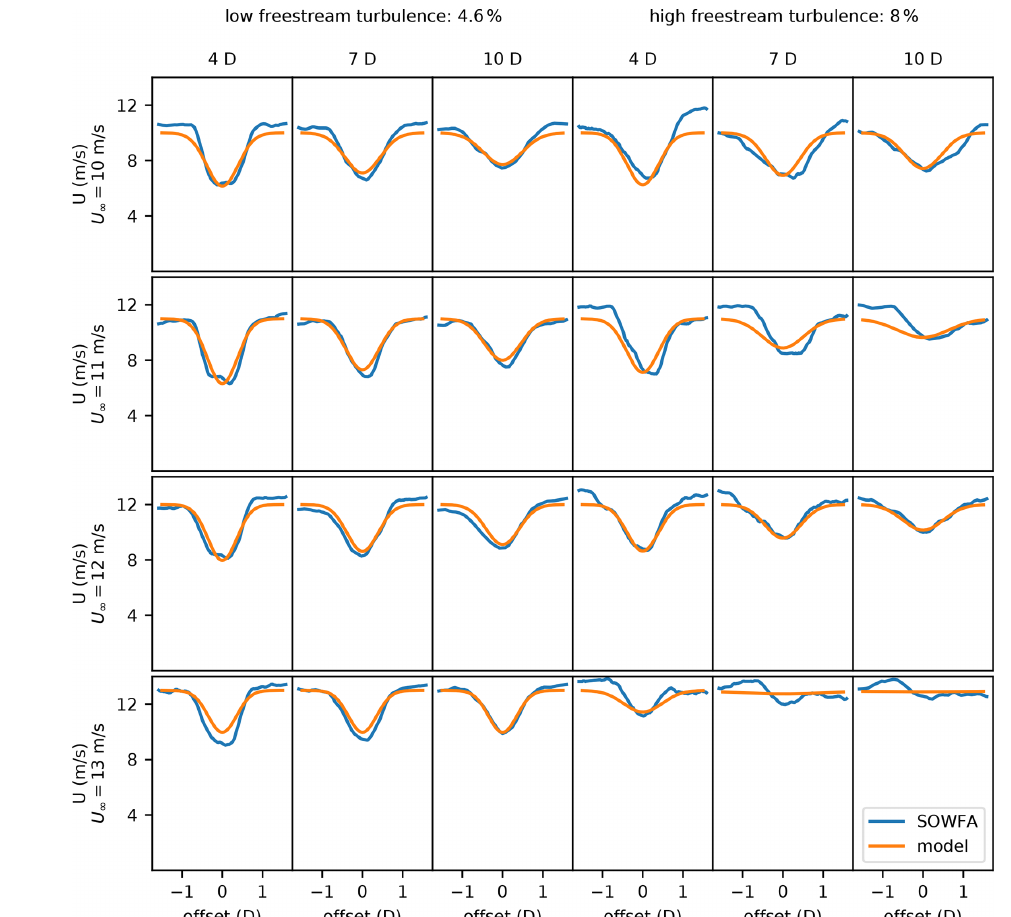
Figure 5. The wind speeds predicted by our large number of eddy simulation data compared to the analytic wake model for freestream turbulence intensities of 4.6% (three left columns) and 8% (three right columns). From left to right, each column represents the wind speeds at 4, 7, and 10 rotor diameters ( D ) downstream of the turbine generating the wake. From top to bottom, each row represents the wind speeds with a freestream wind speed of 10, 11, 12, and 13ms − 1 .